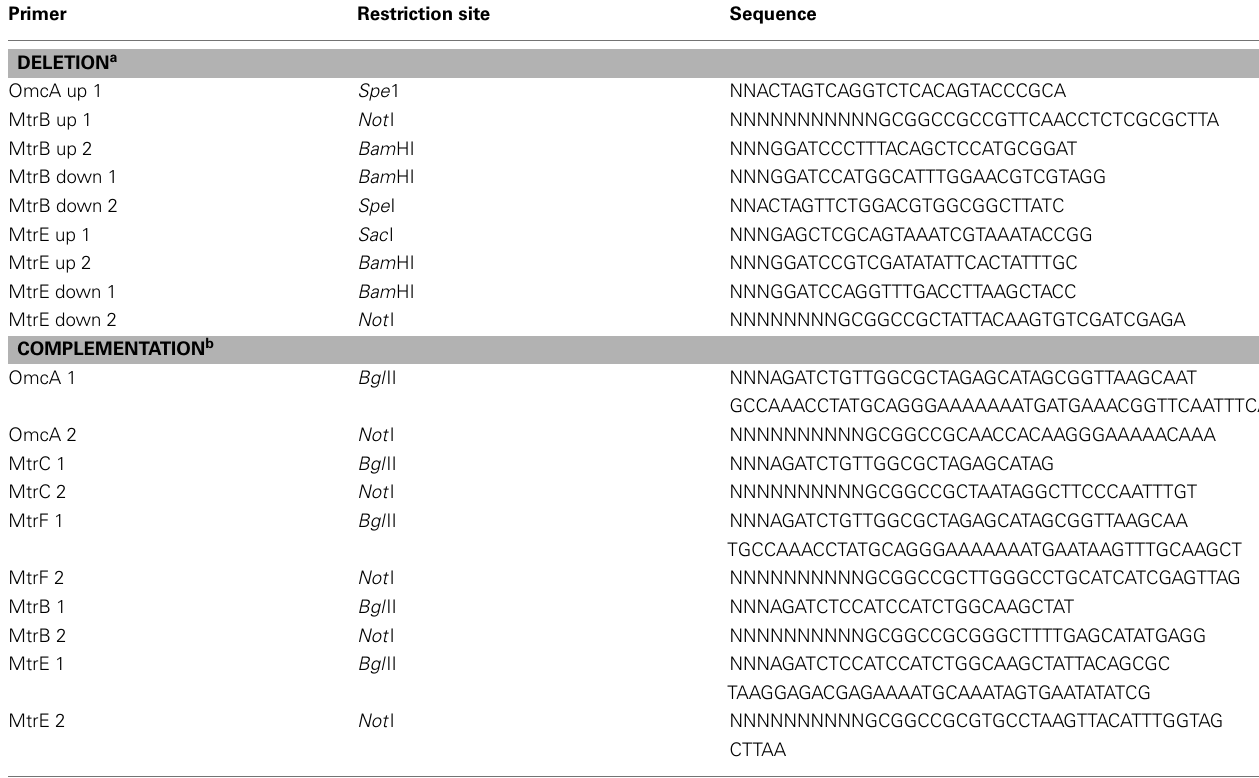
TableA1 | Primers and restriction sites used for cloning and subsequent generation of mutant and complemented